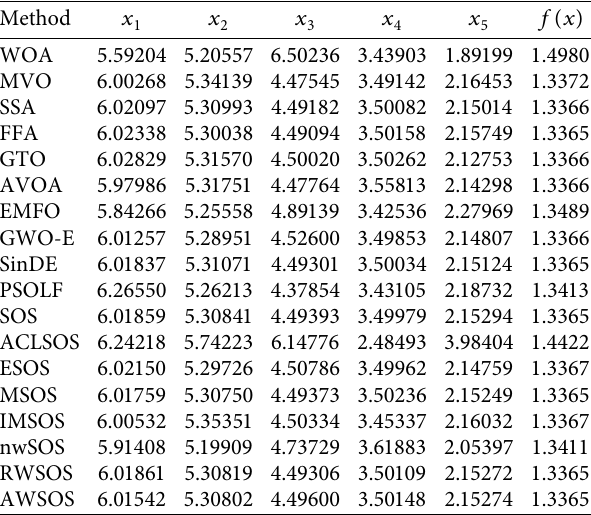
Table 23: Comparison of results on the cantilever beam design problem.